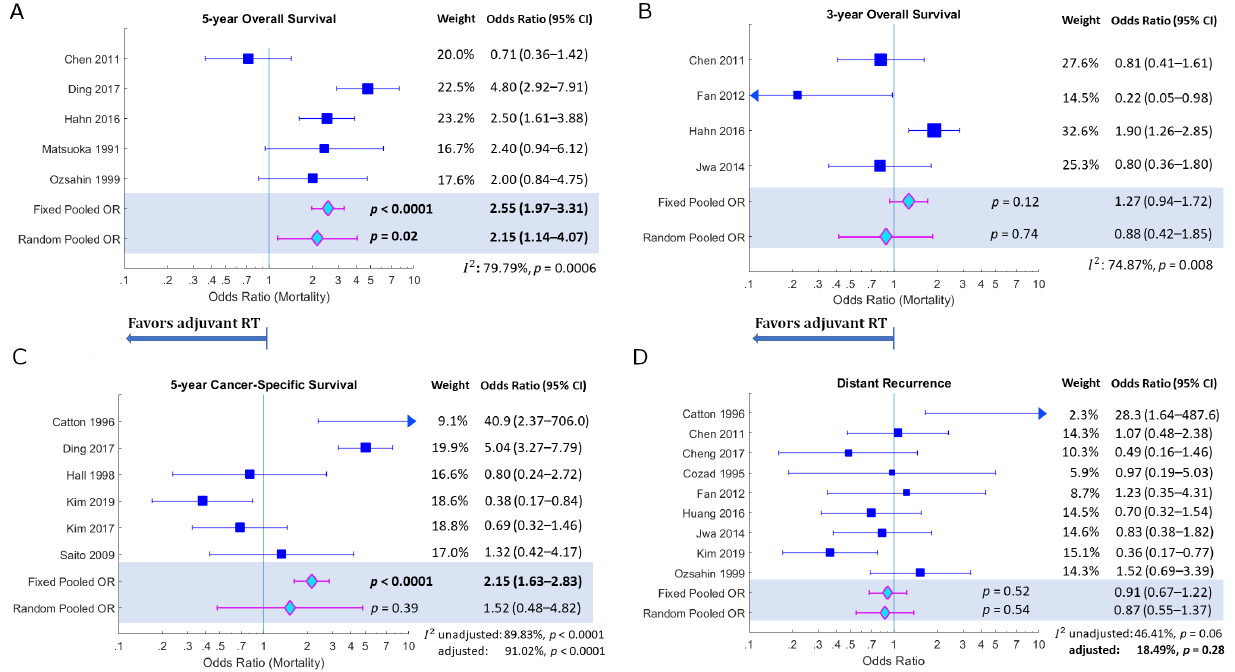
Figure 3. Forest plots for secondary outcomes of ( A ) 5-year overall survival; ( B ) 3-year overall survival; ( C ) 5-year Cancer-Specific Survival; and ( D ) Distant Recurrence.